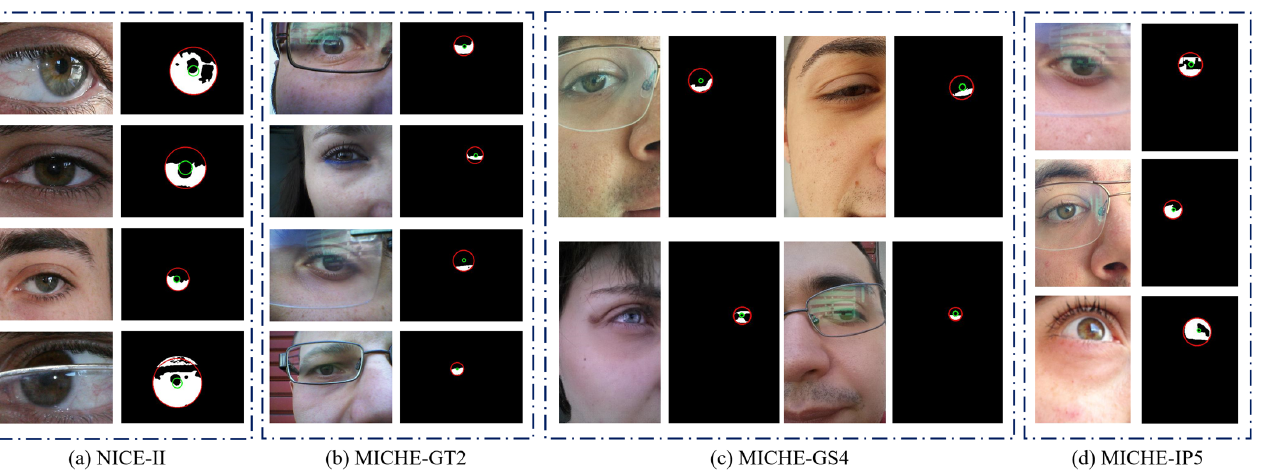
Figure 6. Example images and corresponding ground truths (including iris inner boundary (green), iris outer boundary (red), and iris mask (white)) of four iris databases. iris outer boundary (red), and iris mask (white)) of four iris